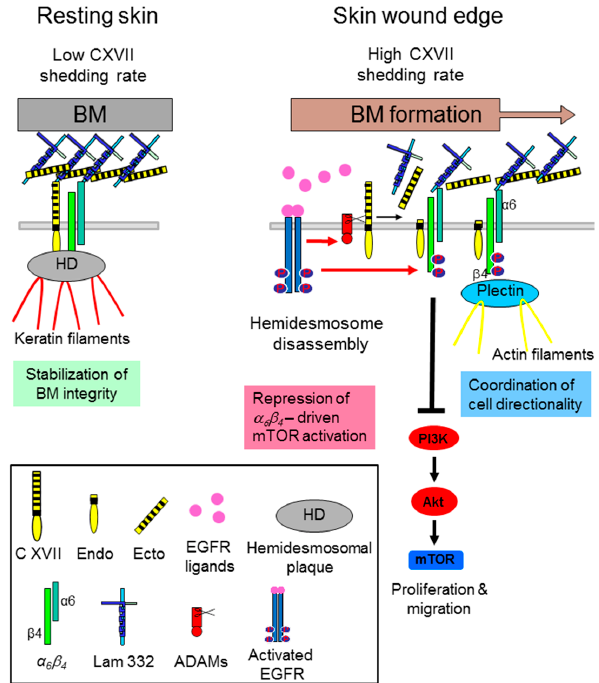
Figure 1. Collagen XVII (C XVII) ectodomain (Ecto) shedding modulates α 6 β 4 integrin-driven motility and proliferation of wound keratinocytes. In resting skin collagen XVII and α 6 β 4 integrin are part of the hemidesmosomal adhesion complexes and the continuously shed collagen XVII ectodomain (low shedding rate) is integrated into the basement membrane (BM). During cutaneous wound healing, when the hemidesmosomes (HDs) at the wound edges are disrupted via epidermal growth factor receptor (EGFR)-mediated phosphorylation of the β 4-subunit, collagen XVII shedding is strongly induced. The released ecto- and endodomains have a repressive function on keratinocyte velocity and proliferation through dampening of α 6 β 4 integrin-driven Akt/ mechanistic Target of Rapamycin (mTOR) pathway activation. While the released ectodomain is part of the newly formed BM surface topography, the membrane tethered endodomain stump seems to be involved in cell-intrinsic motility via formation of the front-to-rear polarity (Figure adapted from [23]). The binding of the integrin receptor to ligands also activates several different pathways including for example FAK/Akt, integrin-linked kinase (ILK), Ras/MAPK/ERK kinase (MEK1/2)/ signal–regulated kinases (ERK) 1/2 and c-Jun NH2-terminal kinase (JNK) [9]. This so-called outside- in signalling is very complex, cell type specific and highly dependent on the type of the integrin heterodimer. Interestingly, further signalling events within a cell have been discussed as a driver for this process. For example the β 4-subunit can be phosphorylated at three serine residues (Ser-1356, Ser-1360, and Ser-1364) by pathways downstream of the epidermal growth factor EGF receptor (EGFR), e.g., ERK1/2 or by protein kinase C (PKC) [39–41]. Therefore, excessive EGFR signalling in tumor cells, seen in a wide variety of types of solid tumors, might have different impact on β 4-subunit phosphorylation and subsequently also on integrin-mediated signalling. In striking contrast to the function of α 6 β 4 integrin in basal keratinocytes (where the integrin is attached to the intermediate filaments) this receptor can instead be attached to the actin cytoskeleton in carcinomas were it stimulates tumor cell migration and invasion [42]. At this point we would like to emphasise